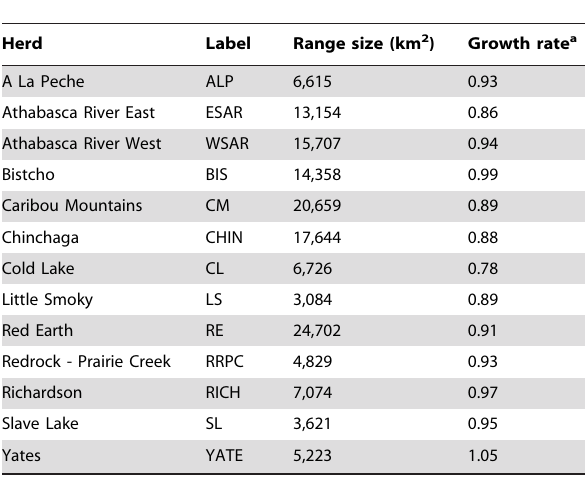
Table 1. Population data for caribou herds in Alberta.